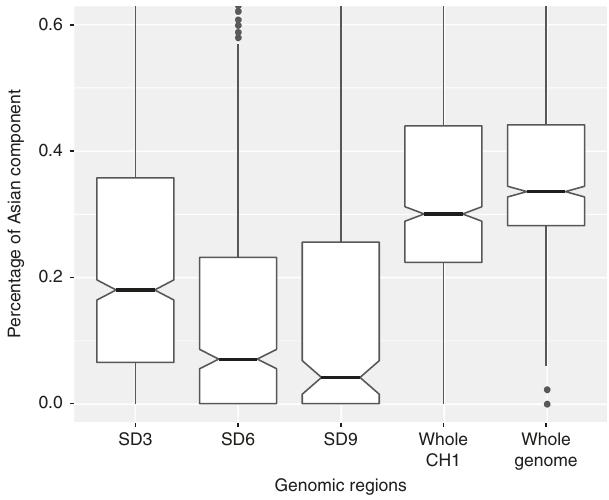
Fig. 2 Asian ancestry proportion of the Malagasy population by genomic region, based on an unsupervised ADMIXTURE analysis for k = 2. SD3 (3 standard deviations from the average ancestry) represents the region chr1: 114423653 – 175653680; SD6 represents the region